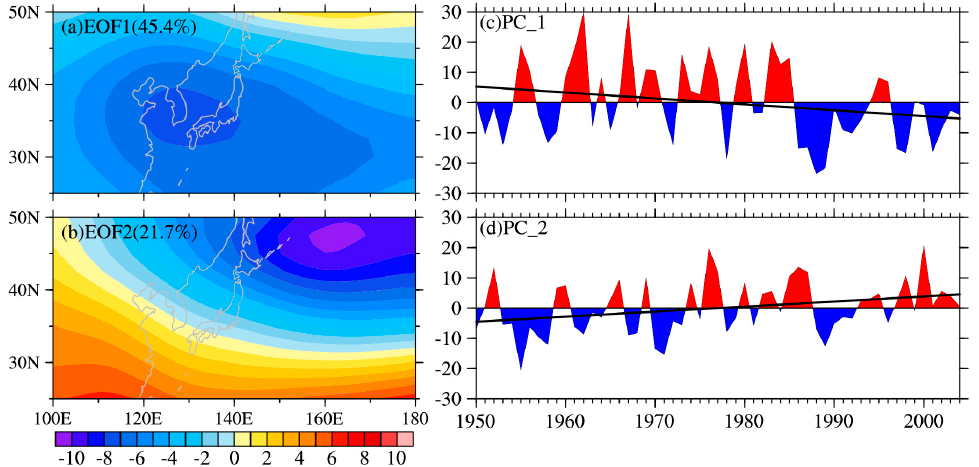
Figure 6. ( a ) First and ( b ) second empirical orthogonal function (EOF) modes of the geopotential height at 500 hPa in the observations and ( c , d ) their time series. The lines in ( c , d ) indicate the linear trends.